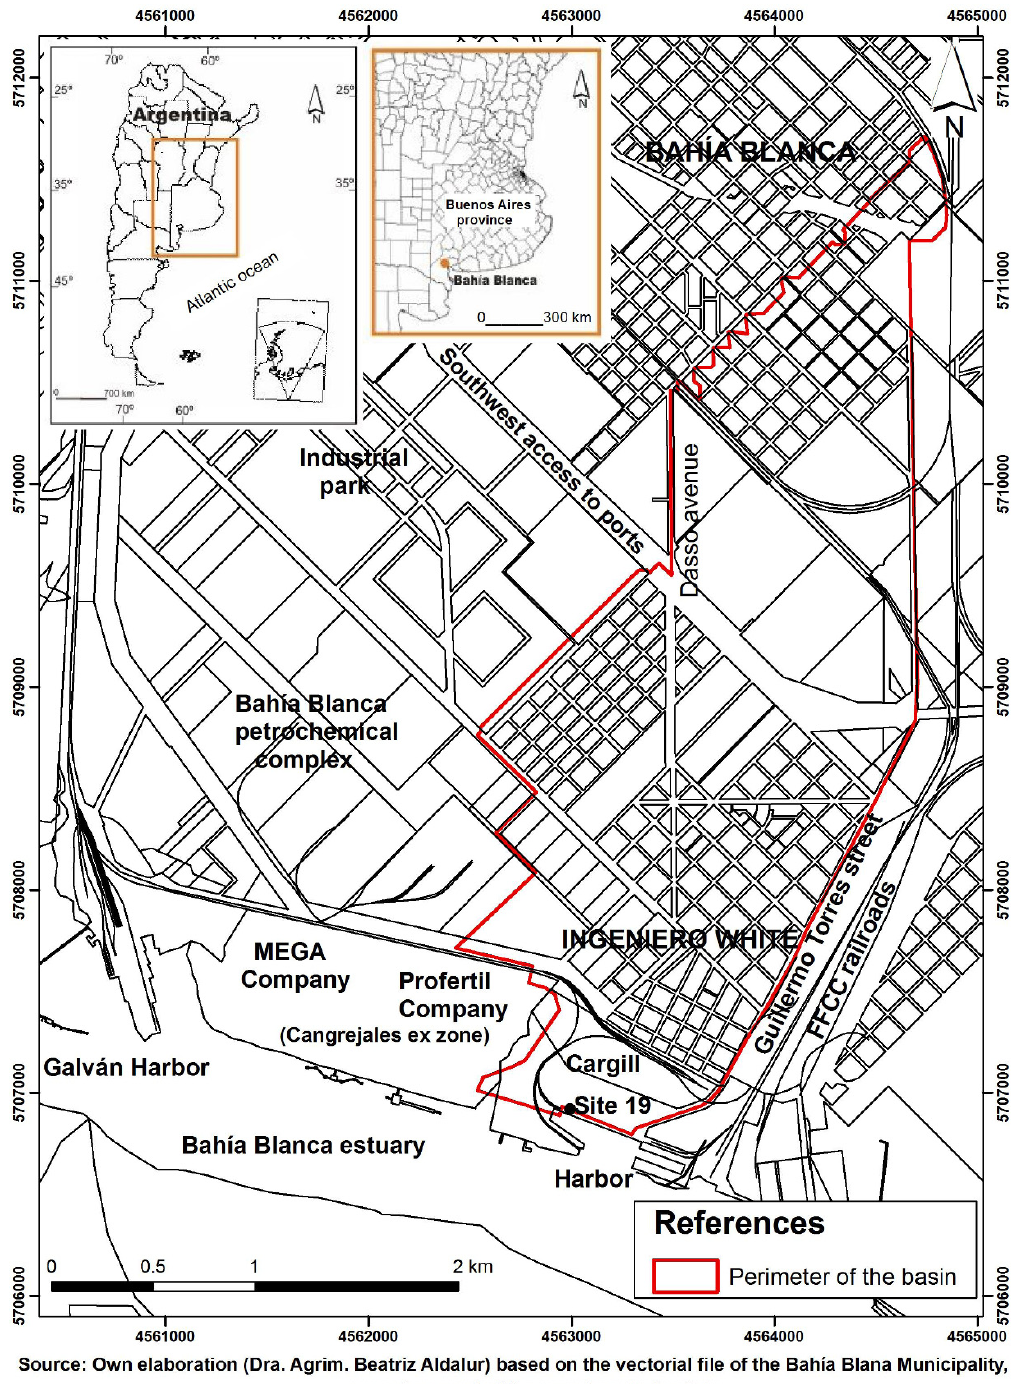
Figure 1. Location of the studied